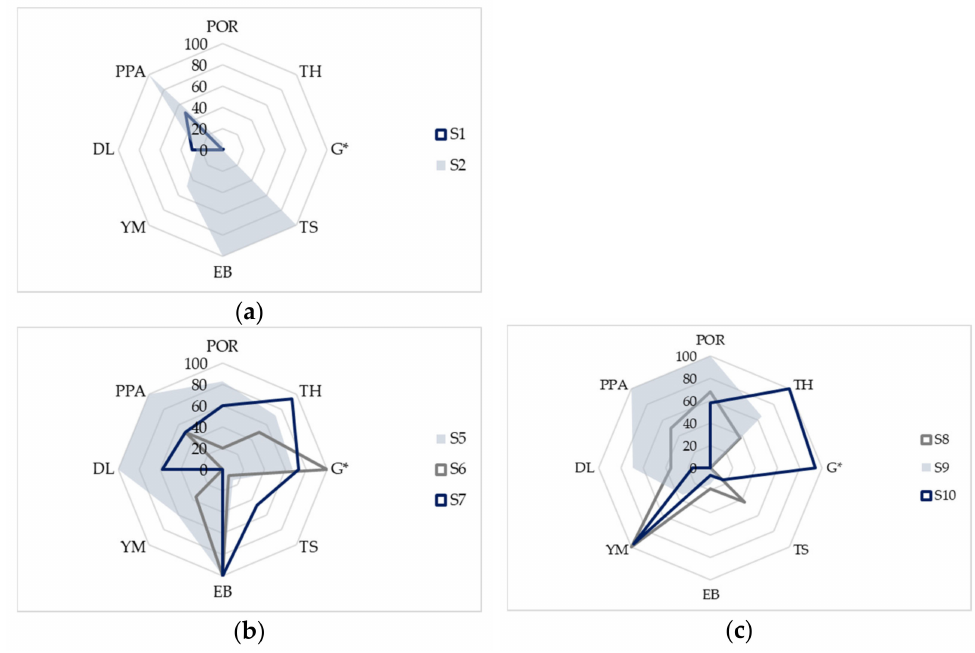
Figure 5. Radar charts for printability assessment of the investigated samples: Subset I ( a ); subset II ( b ) and subset III ( c ). POR—porosity, TH—thickness, DL—drug load and PPA—printed pattern appearance. Within the subset III, samples S8 and S10 had similar relative surface areas (23.5% and 23.7%, respectively), although different parameters contributed to their